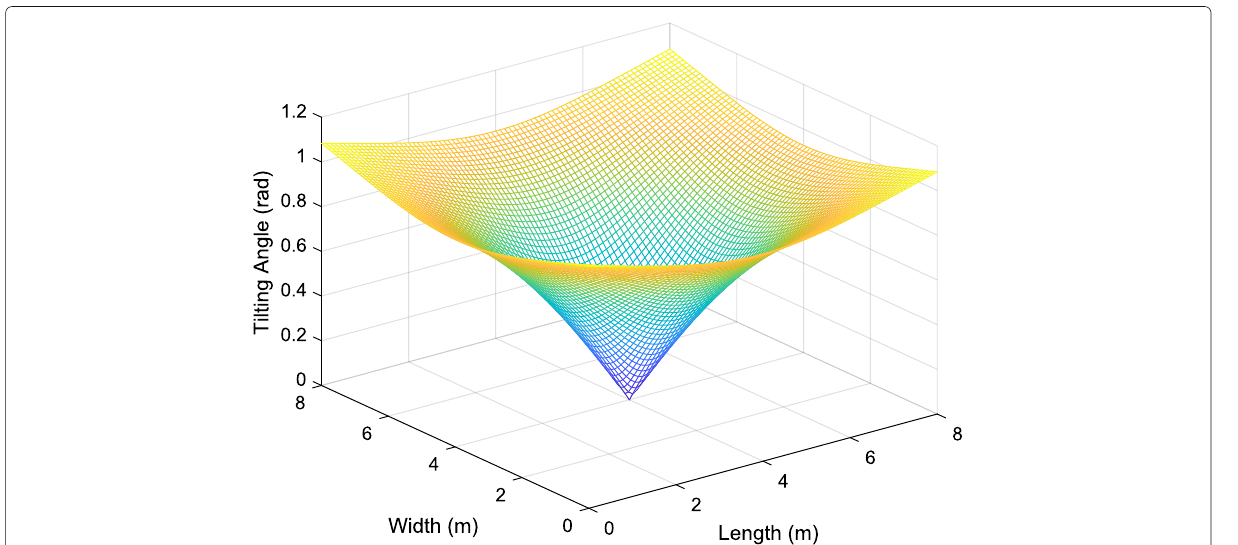
Fig. 9 Tilting angle distributions after tilting the receiver plane in the